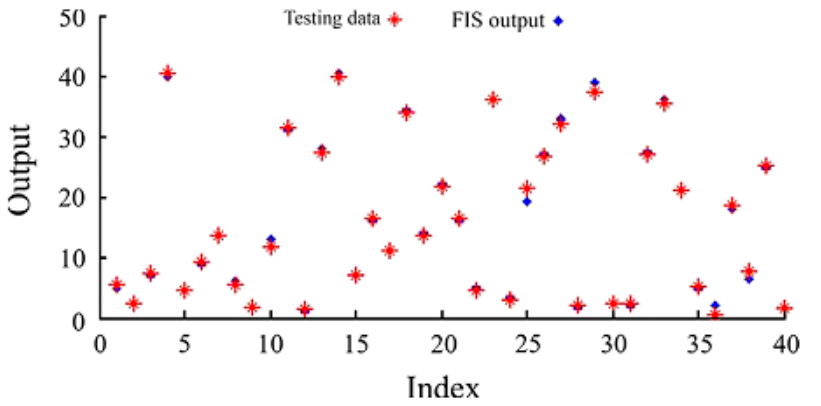
Figure 8. A comparison between the fuzzy inference system (FIS) outputs and testing data. Adapted